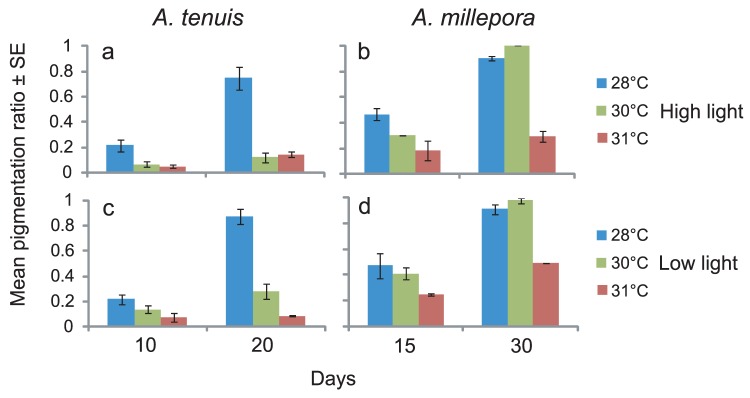
Pigmentation ratios (±1 SE) of coral juveniles kept at 28, 30, or 31°C and under high light (a,b; 390 µmol photons m−2 s−1) or low light (c,d; 180 µmol photons m−2 s−1) levels.Pigmentation ratios were calculated after 10 (A. tenuis a, c) or 15 (A. millepora b, d) days of exposure to Symbiodinium, and again after a further 10 or 15 days in filtered sea water (1 µm) without additional exposure to Symbiodinium. See Table 1 for sample sizes.